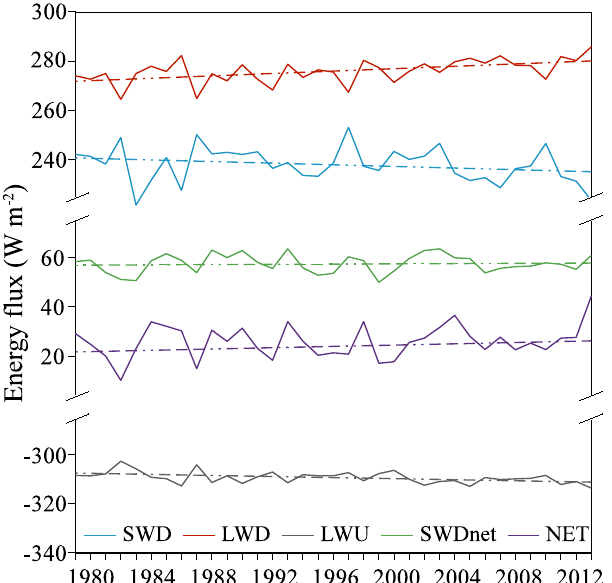
Figure 8. Evolution of the JJA energy balance components fluxes (Wm − 2 ) simulated by MAR ERA over the permanent ice area with their linear trends in dashed